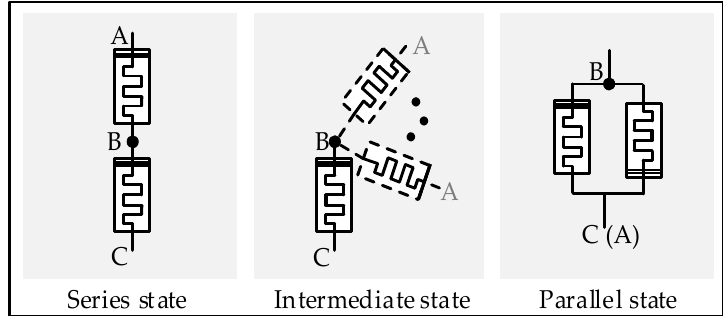
Figure 6. The circuit diagram of rotation mechanism.